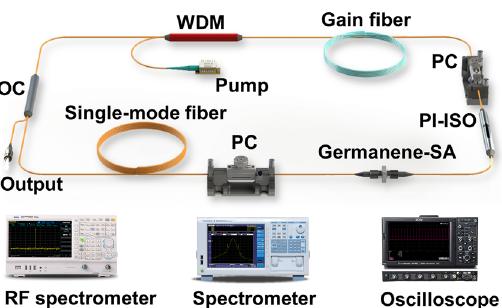
Figure 5: Experimental setup of germanene-SA based mode-locked EDFL and